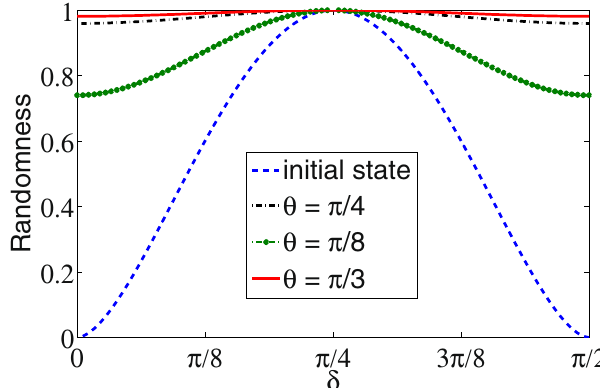
Figure 1. Intrinsic randomness in the coin space (particle) as a function of initial state parameter δ before implementing quantum walk and after implementing 50 step of quantum walk using difference coin operation parameter θ . Though we see some dependency on δ , a significant enhancement of randomness is seen even when the randomness in the initial state is